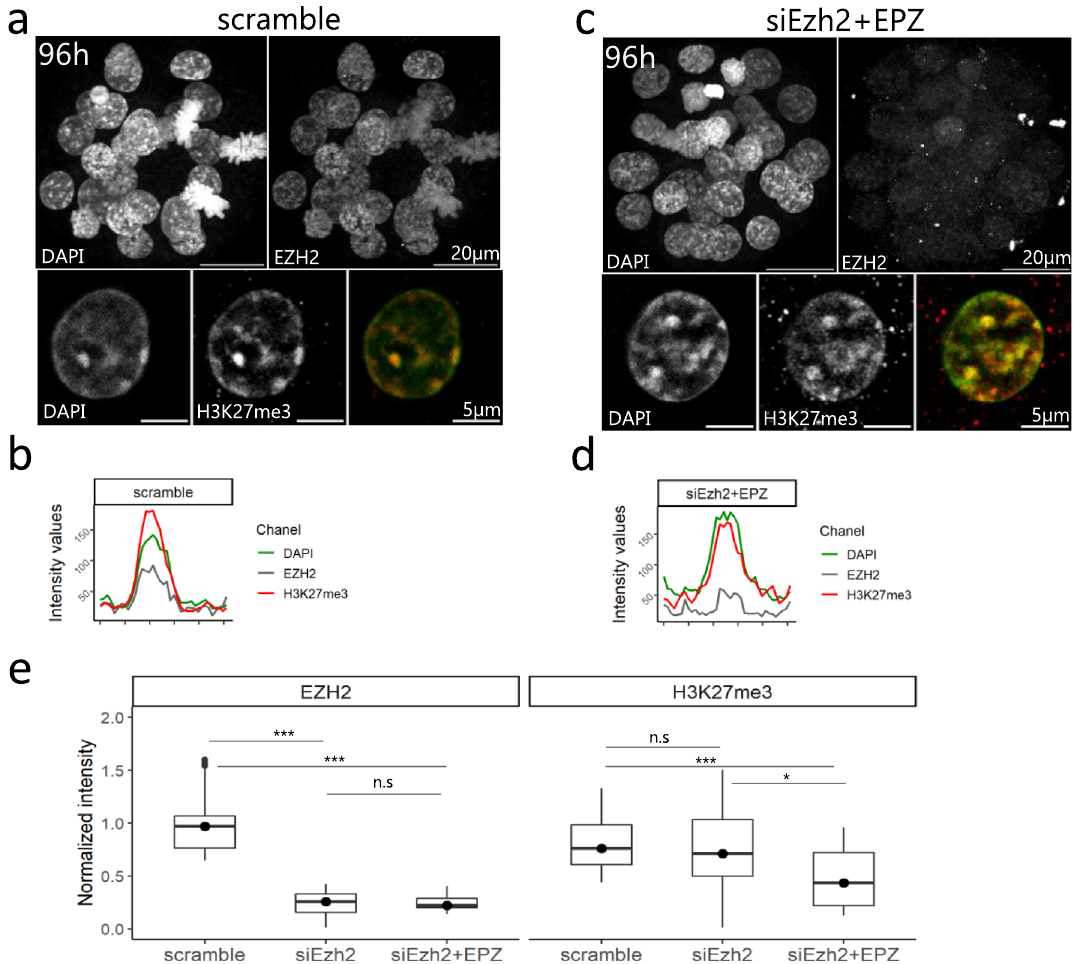
Figure 6. Knock-down of EZH2 and its effects on H3K27me3 accumulation at PCH. ( a , c ) Early blastocysts at 96 h of culture after electroporation with scramble ( a ) or siEzh2 ( c ) and stained for EZH2 (grey), DAPI (green) and H3K27me3 (red). Upper panels show a z-projection of a whole embryo, while lower panels show a representative nucleus. ( b , d ) The graphs show the intensity profiles of DAPI, H3K27me3 and EZH2 signals across a single chromocenter. ( e ) Quantification of total signal intensity of EZH2 and H3K27me3 in nuclei (n = 20) of scramble, siEzh2 and siEzh2 + EPZ treated embryos. *** Pvalue < 10 −3 ; ns = non significant; Mann– Whitney test. Graphs were generated using ggplot2 56 (v3.3.5) in R and figures were arranged with FigureJ 55 in Fiji 54